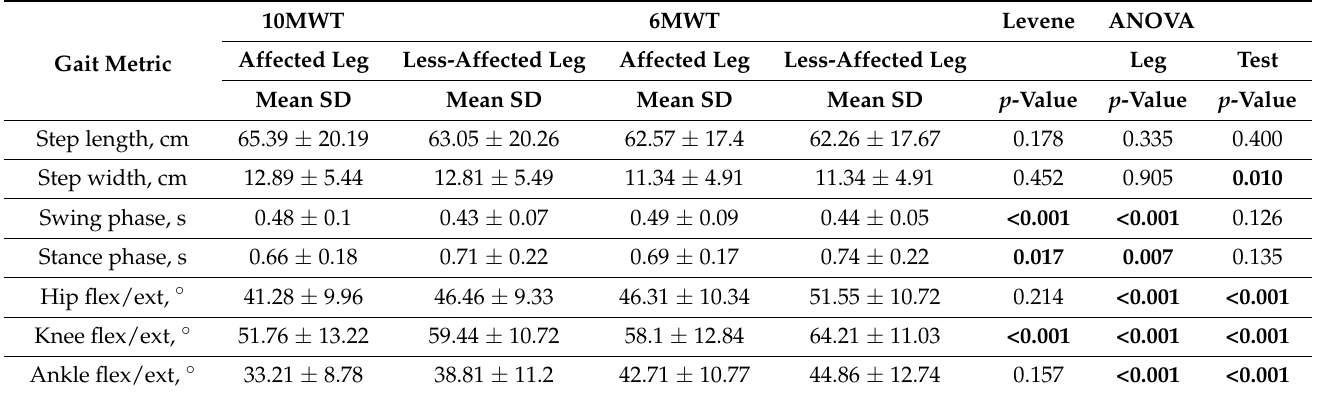
Table 3. Comparison of the affected vs. less-affected leg and 10MWT vs. 6MWT per gait metric.